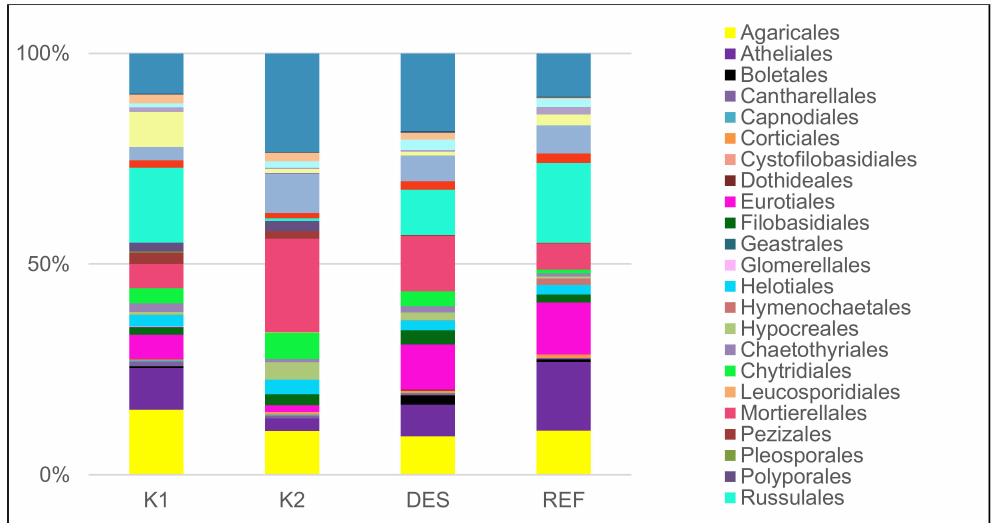
Figure 3. Average relative abundance of sequences assigned to fungal orders from 10 microsites per forest that is attacked by bark beetle (K1), destroyed by bark beetle (K2), with removed trees (DES), and mature